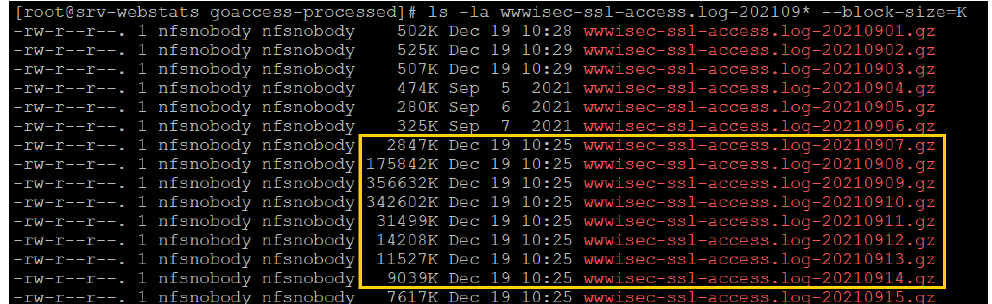
Figure 8. Log file size in September.